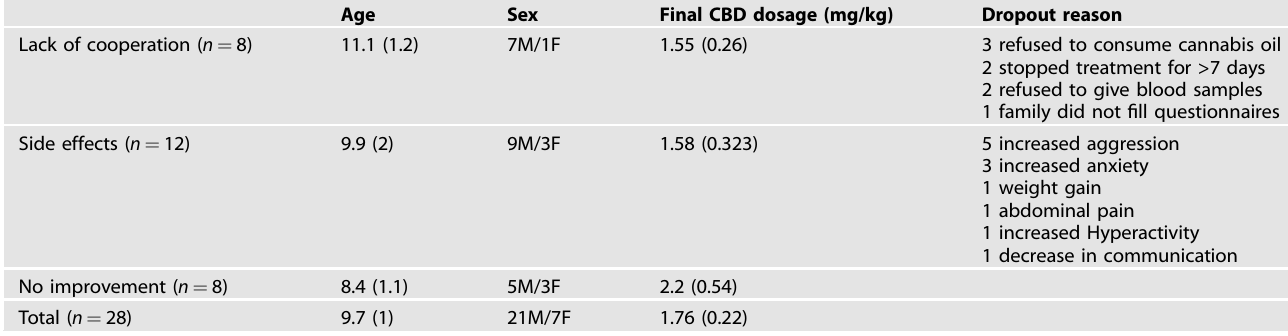
Table 3. Characteristics of participants who dropped out of the study.